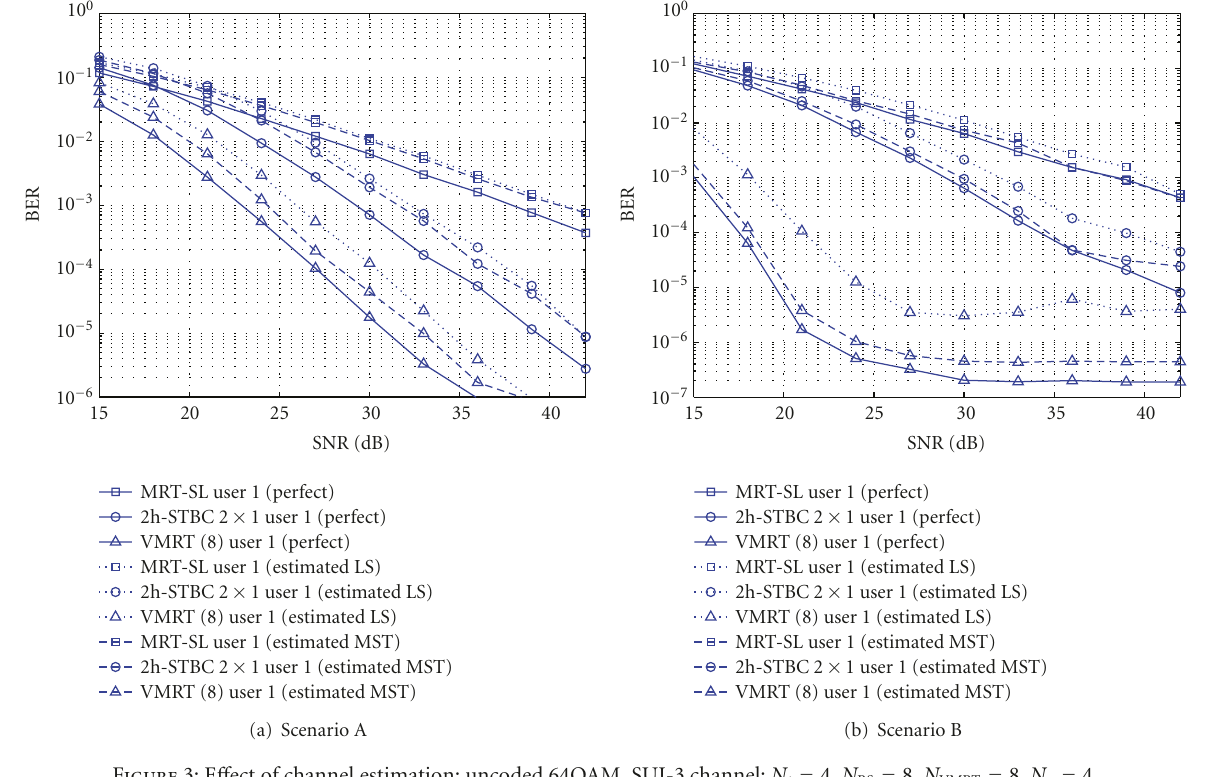
Figure 3: E ff ect of channel estimation: uncoded 64QAM, SUI-3 channel; N t = 4, N RS = 8, N VMRT = 8, N u = 4.